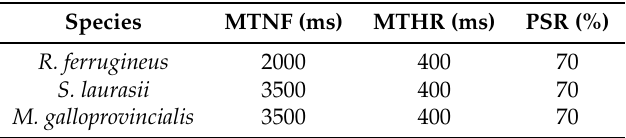
Table 4. Parameters used for processing recorded events.